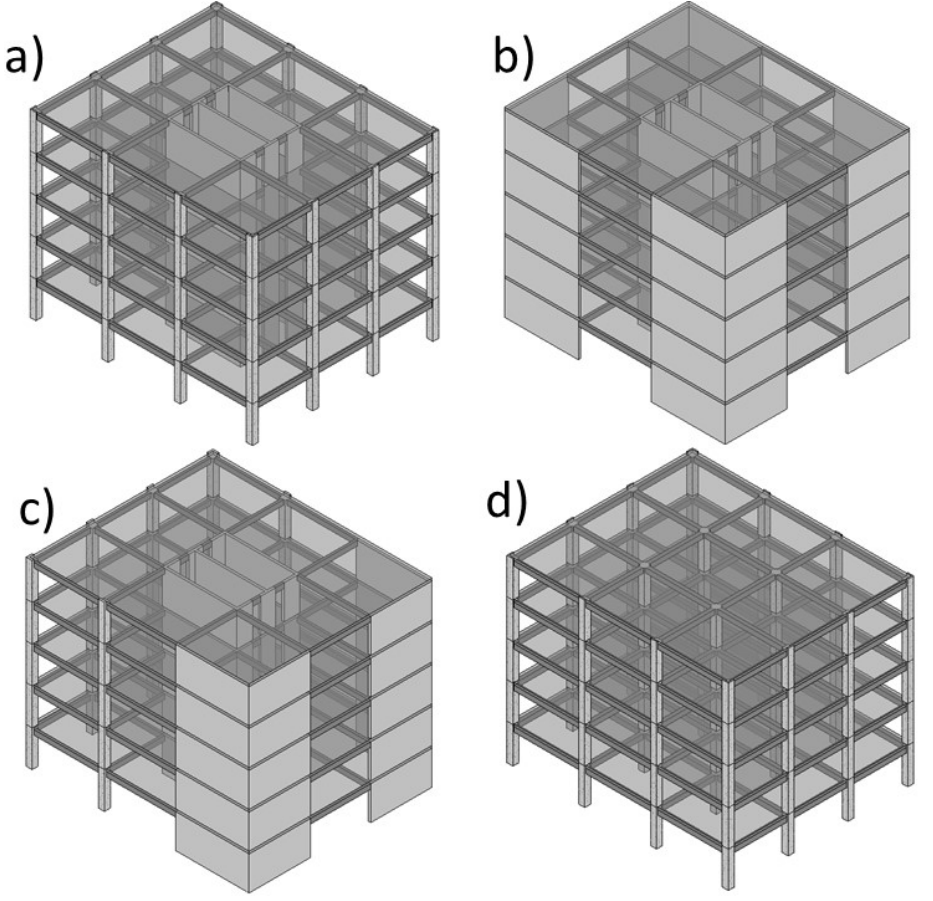
Figure 8. Isometric views of the archetypes studied: ( a ) Archetype 1 with a semi-rigid structure made up of frames and a core of shear walls, ( b ) Archetype 2 with a rigid structure made up of shear walls, ( c ) Archetype 3 with a semi-rigid structure made up of frames and shear walls distributed asymmetrically, and ( d ) Archetype 4 with a flexible structure made up of frames.